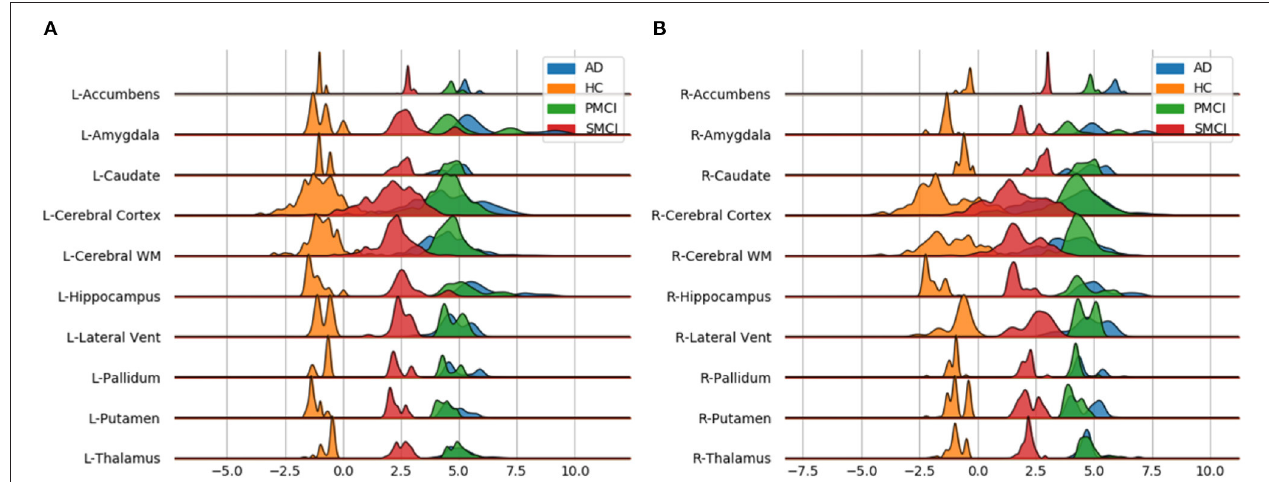
FIGURE 11 | Subcortical ROI-based difference in voxel level brain-PAD scores averaged across participants from clinical groups from OASIS3. X axis shows brain-PAD values within the given ROI; HC, Healthy controls; sMCI, stable MCI; pMCI, progressive MCI; AD, Alzheimer’s disease. (A) Left Hemisphere; (B) Right Hemisphere.